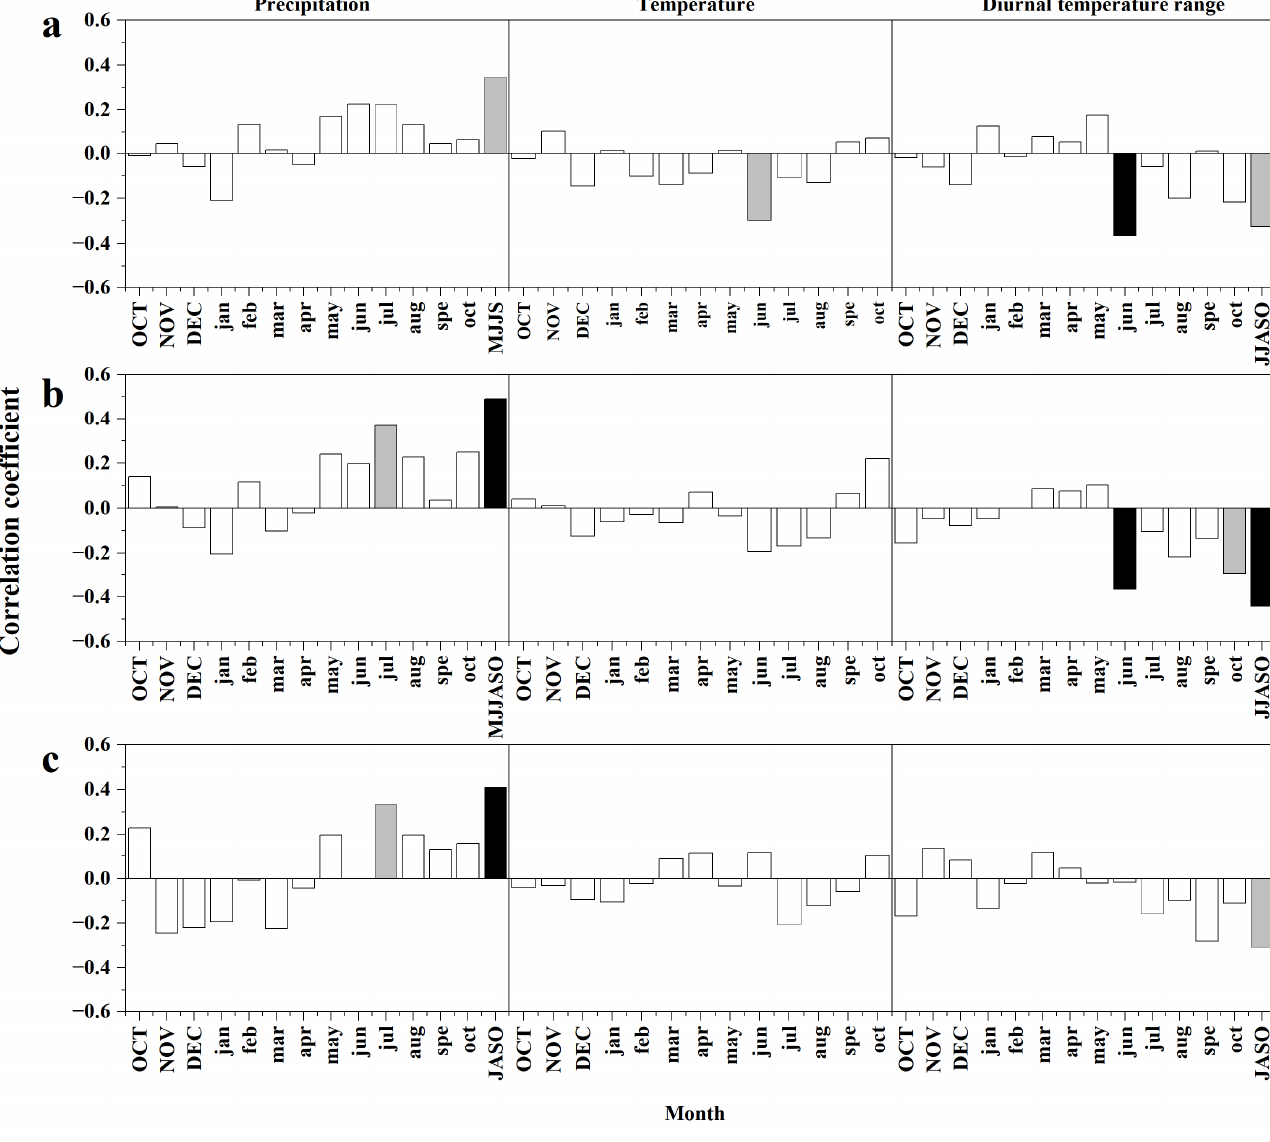
Figure 7. The correlation plots for ( a ) tree-ring width (TRW), ( b ) latewood width (LWW), ( c ) latewood ratio (LWR) with monthly mean precipitation (left), monthly mean temperature (center) and diurnal temperature range (right). The correlations were calculated from previous (capital letter) October to current (lowercase letters) October, with significant correlations shown in grey ( p < 0.05) and black ( p < 0.01). MJJAS: the period from May to September, JJASO: the period from June to current October, MJJASO: the period from May to October, JASO: the period from July to